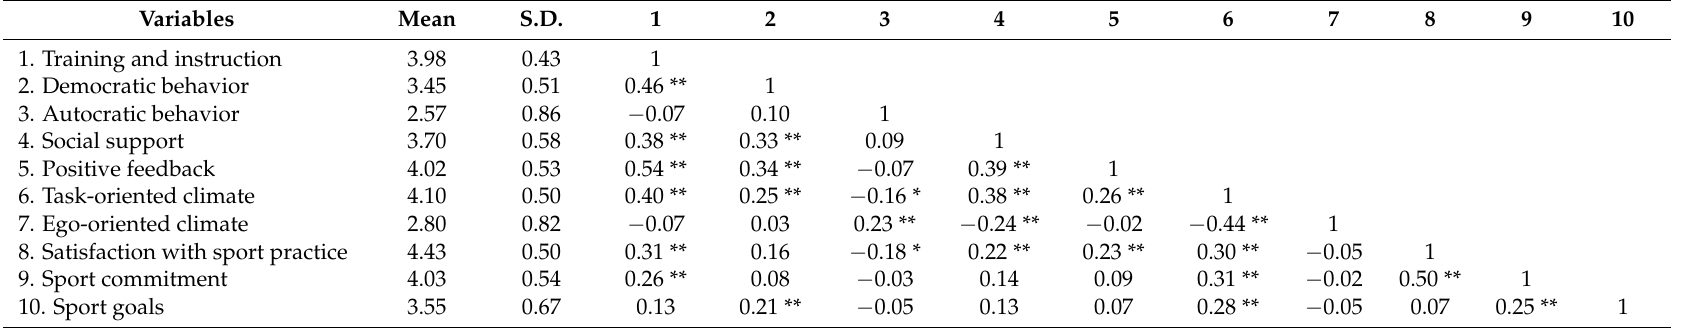
Table 1. Pearson’s correlation matrix of study variables.